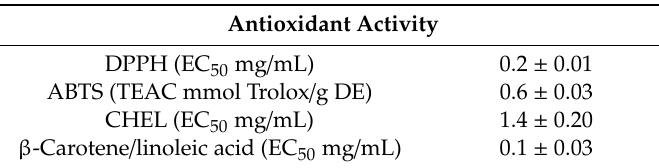
Table 5. The antioxidant activity (2,2-diphenyl-1-picryl-hydrazyl free radical scavenging assay (DPPH), 2,2 (cid:48) -azinobis[3-ethylbenzthiazoline]-6-sulfonic acid decolorization assay (ABTS), metal chelating (CHEL), β -carotene bleaching protocol) of extract from the leaves of P. rotundifolia . Each value is expressed as mean ± standard deviation ( n = 3). Radical scavenging activity or DPPH for ascorbic acid (standard)EC 50 = 0.08 ± 0.03mg / mL;metalchelatingactivity(CHEL)forethylenediaminetetraaceticacid (EDTA) (standard) EC 50 = 0.45 ± 0.07 mg / mL; β -carotene bleaching assay for butylated hydroxytoluene (BHT) (standard) EC 50 = 0.02 ± 0.01 mg / mL; DE—dry